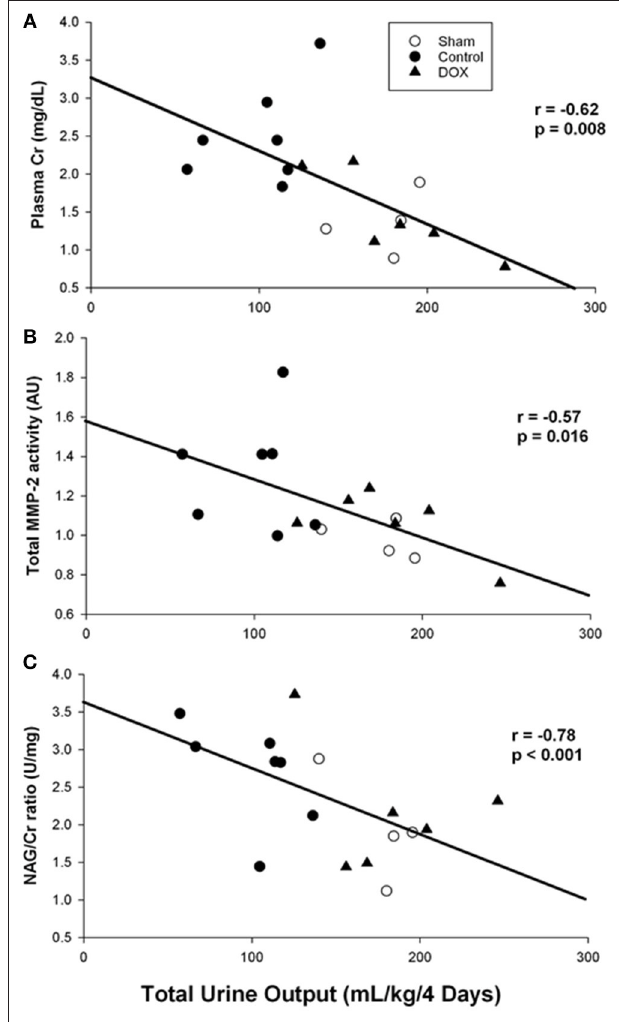
FIGURE 4 | Correlation between total urine output and (A) plasma creatinine level, (B) total MMP-2 activity, and (C) urine NAG/Cr ratio (Pearson Product Moment